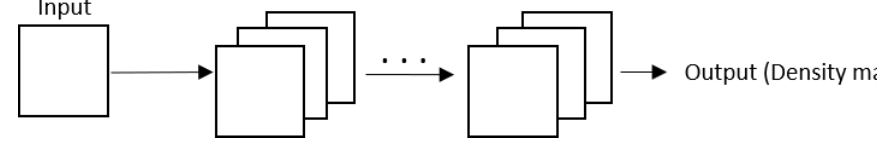
Figure 4. General structure of the Basic CNN